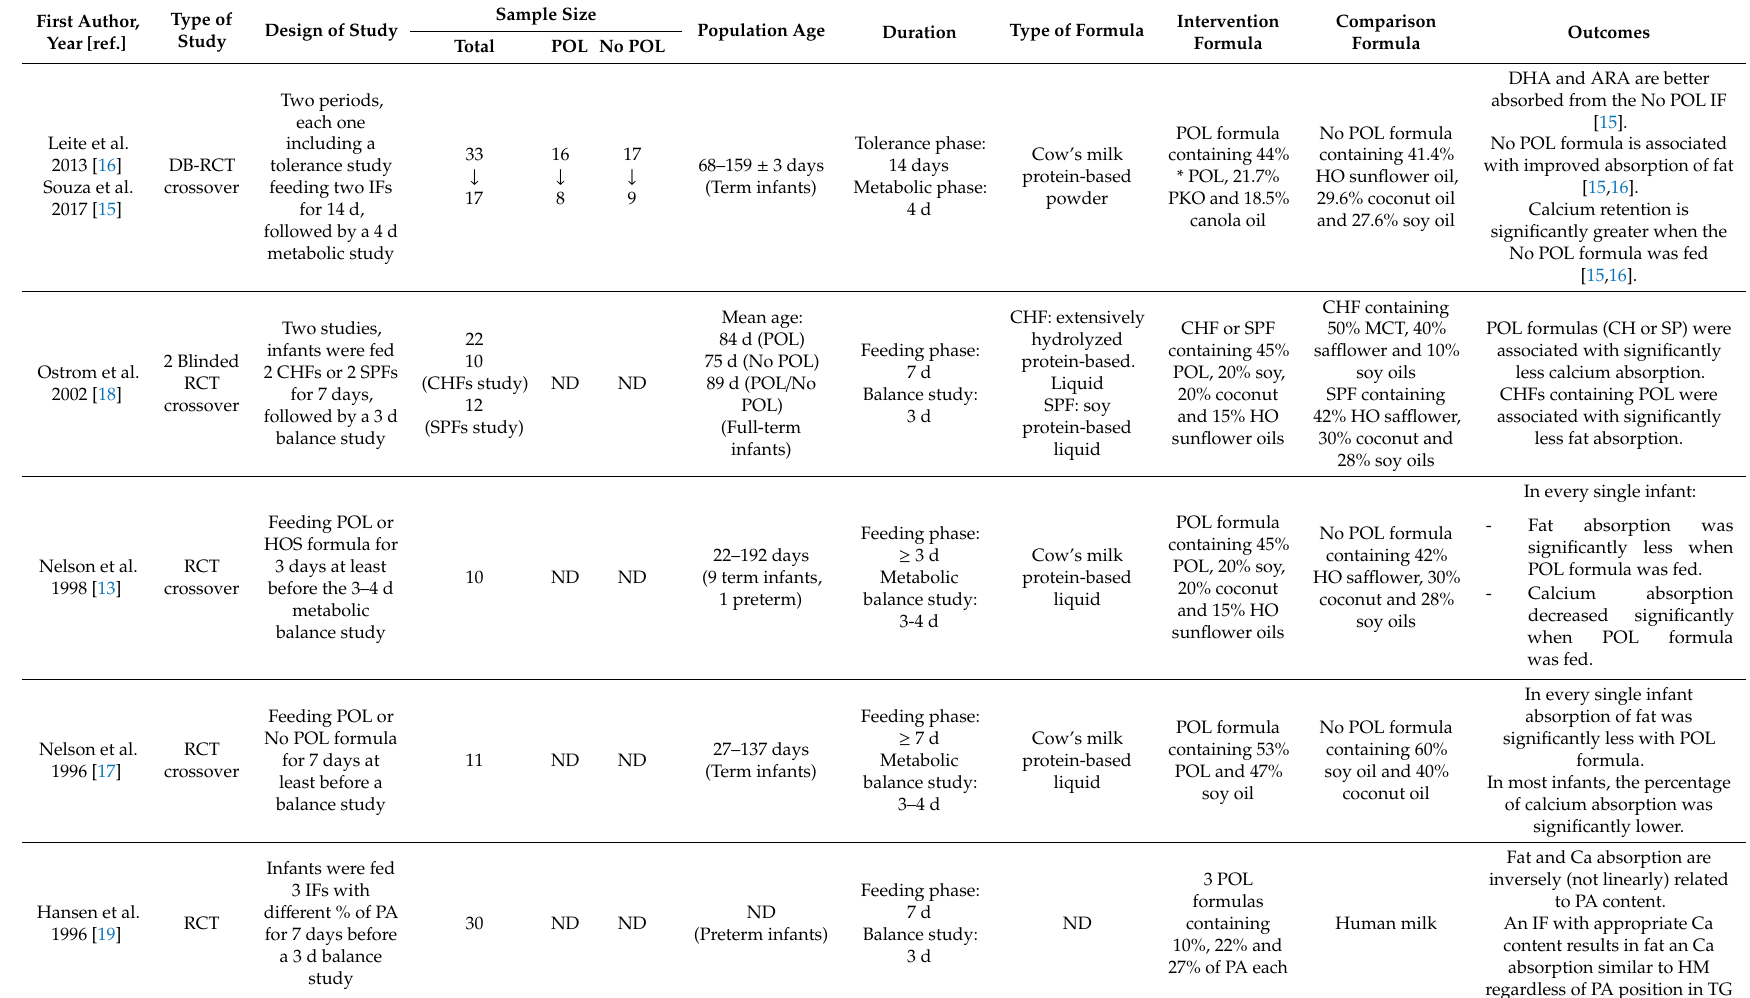
Table 2. Characteristics of studies describing fat and calcium absorption e ff